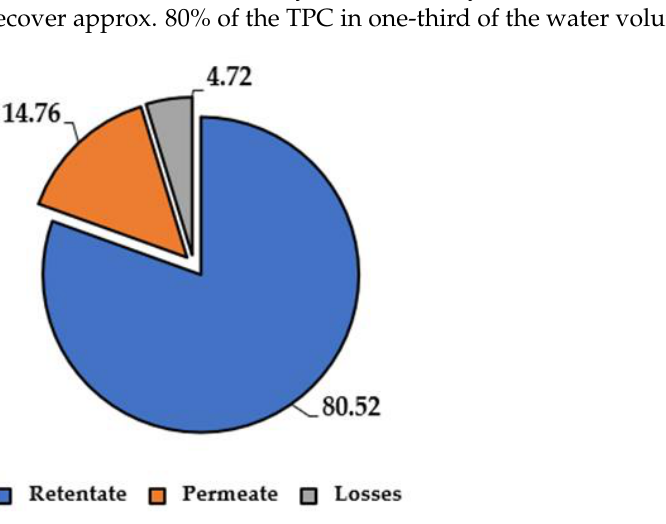
Figure 10. UF, TPC mass balance, expressed as percentage on TPC.